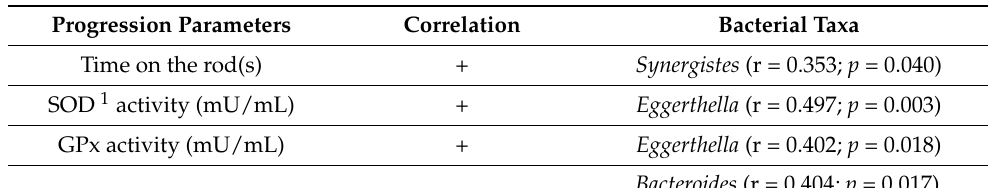
Table 2. Correlations between the taxa abundance of bacterial genera and parameters of Parkinson’s disease progression.